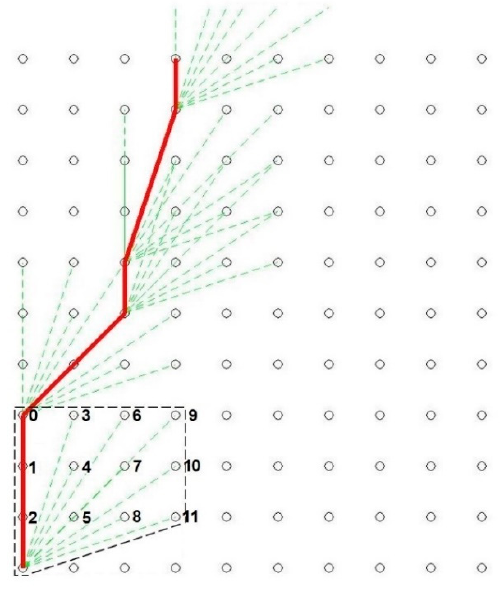
Figure 5. Visualized trajectory (determined in step 1) of an anti-collision manoeuvre in the discretized space and a marked area of steady rudder setting for starting conditions corresponding to the current ship’s state vector.